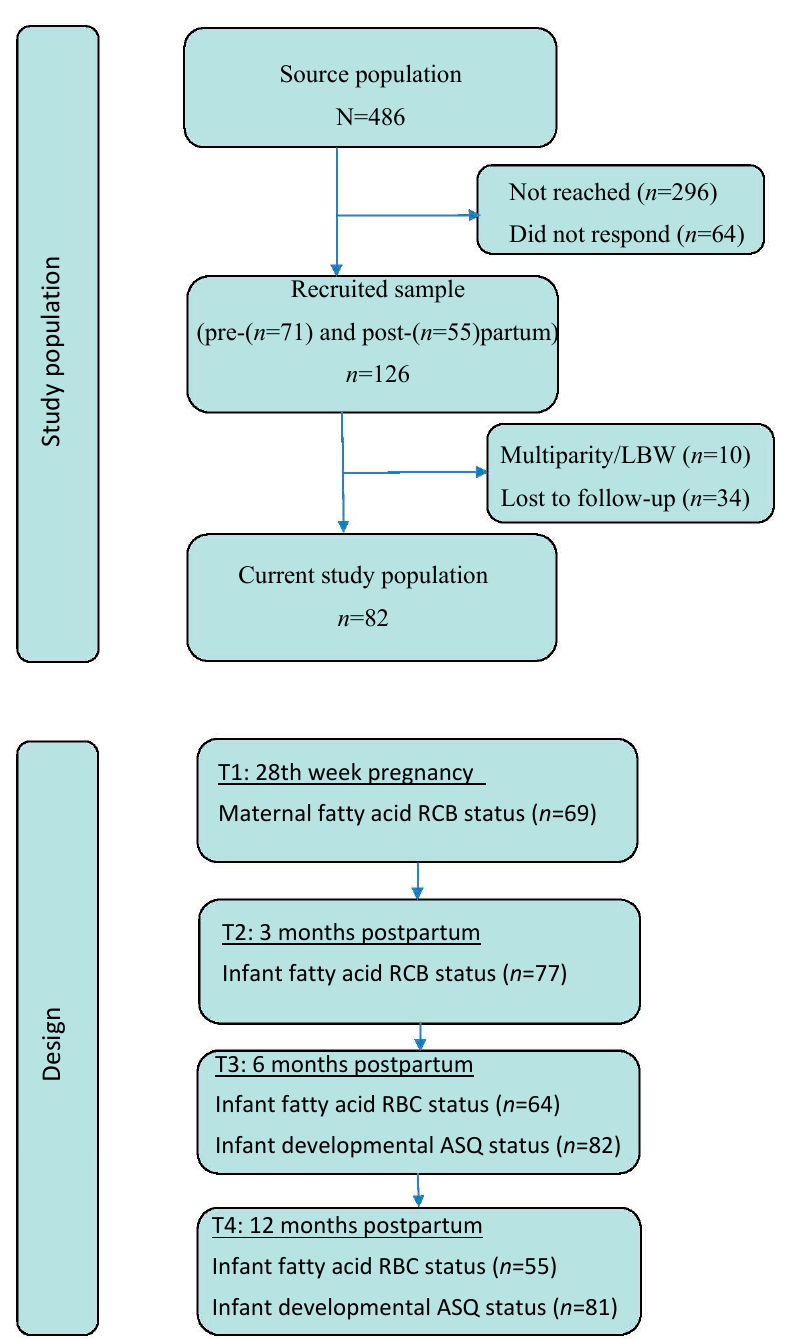
Figure 1. Flowchart depicting study population and design. ASQ: Ages and Stages Questionnaire; LBW: low birth weight; RCB: red blood